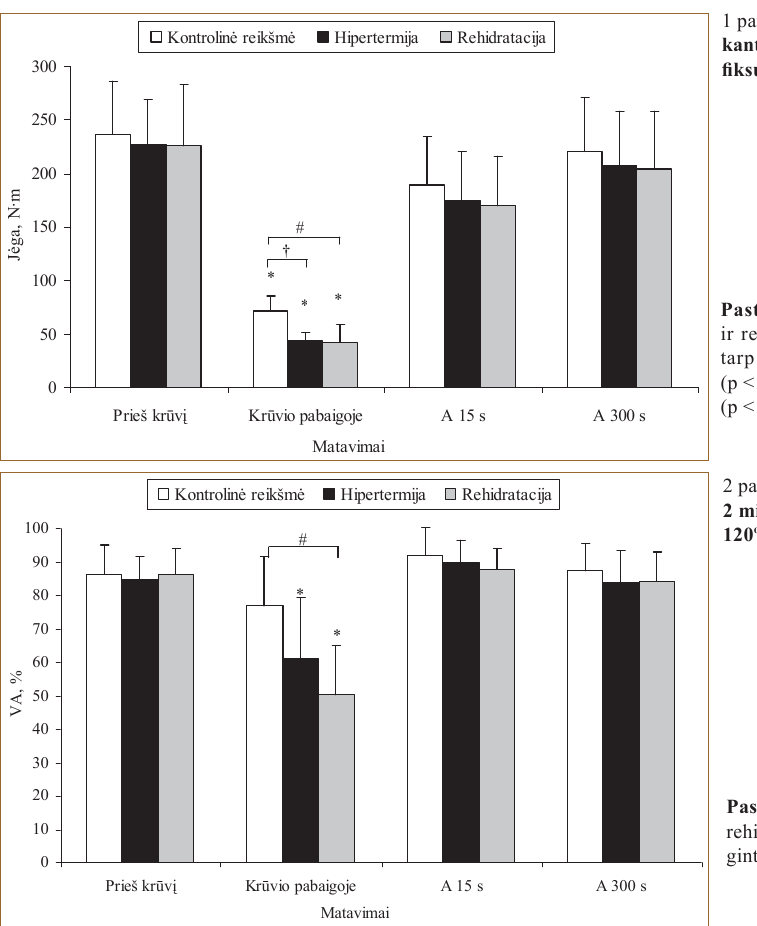
ginti su pradine reikšme (p <